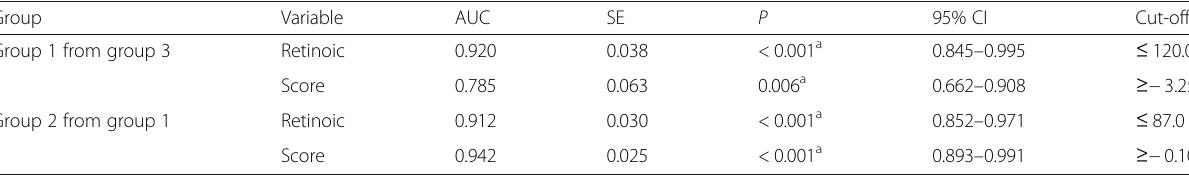
Table 4 Diagnostic performance of retinoic acid and NAFLD score in differentiation between the studied groups Group